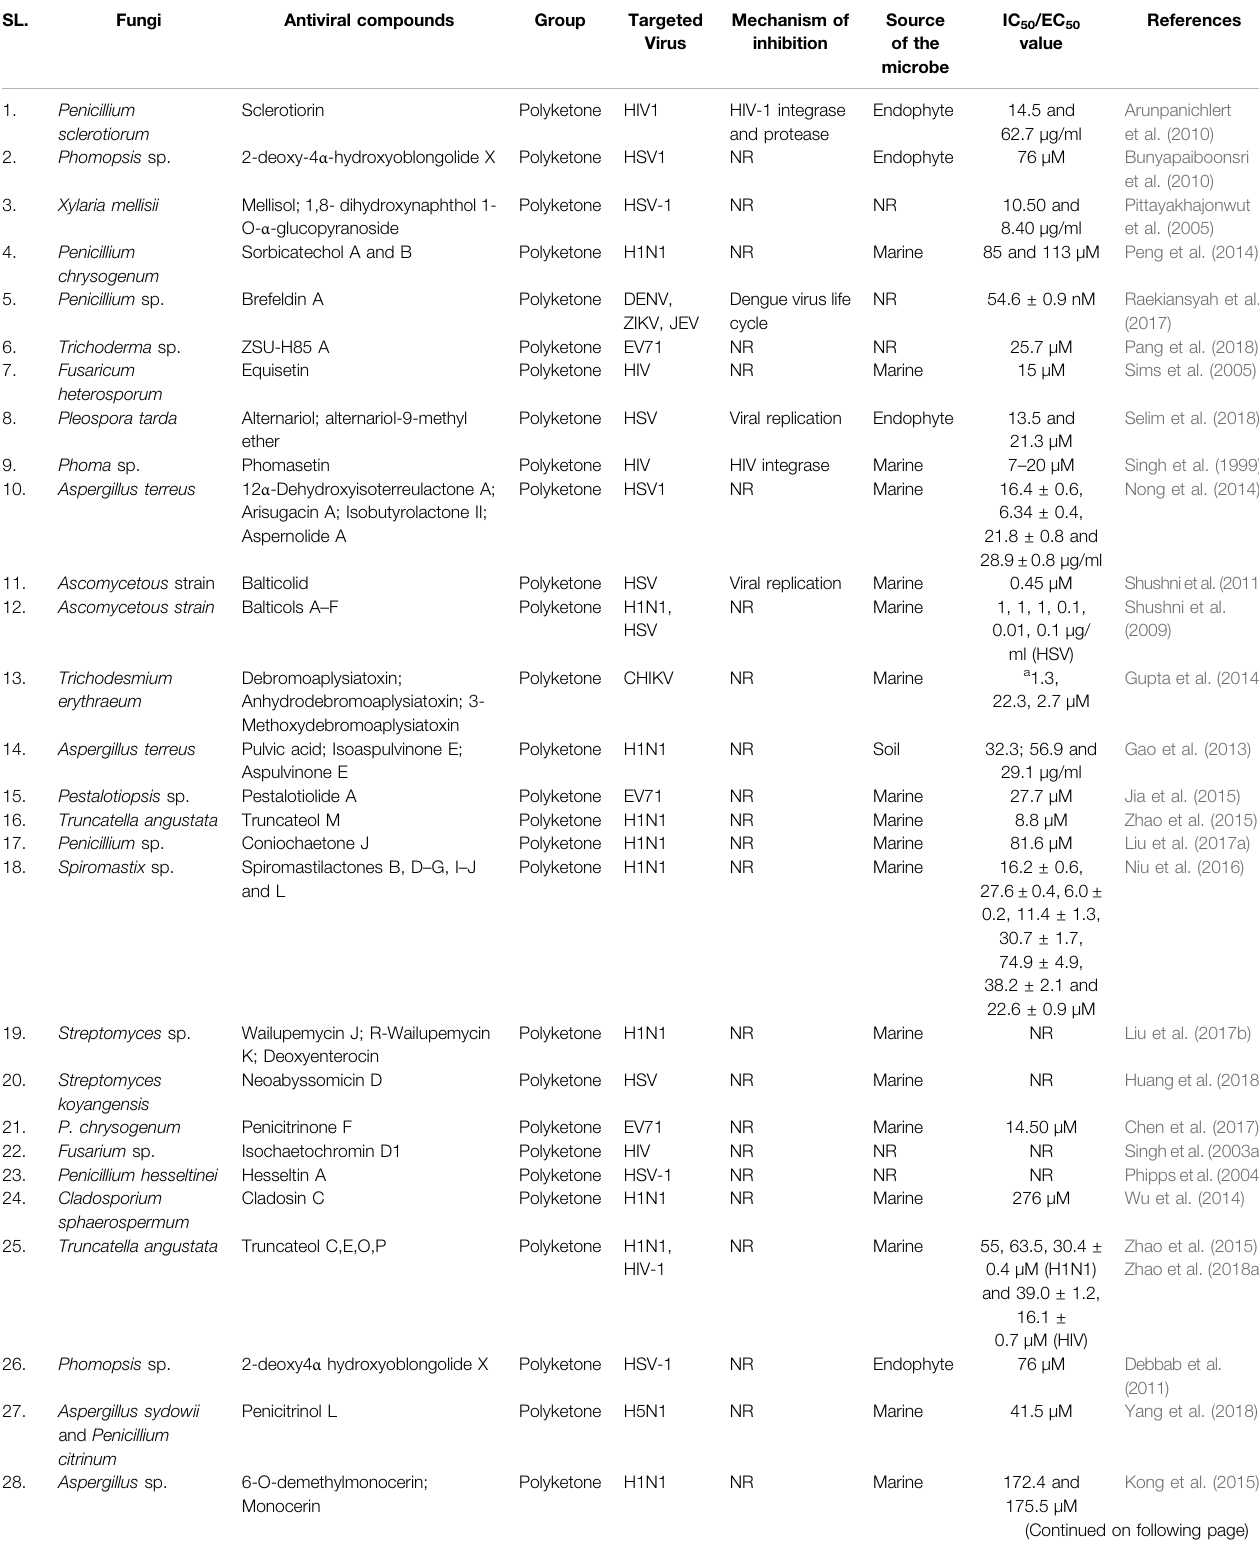
TABLE 1 | Antiviral bioactive compounds isolated from fungi.